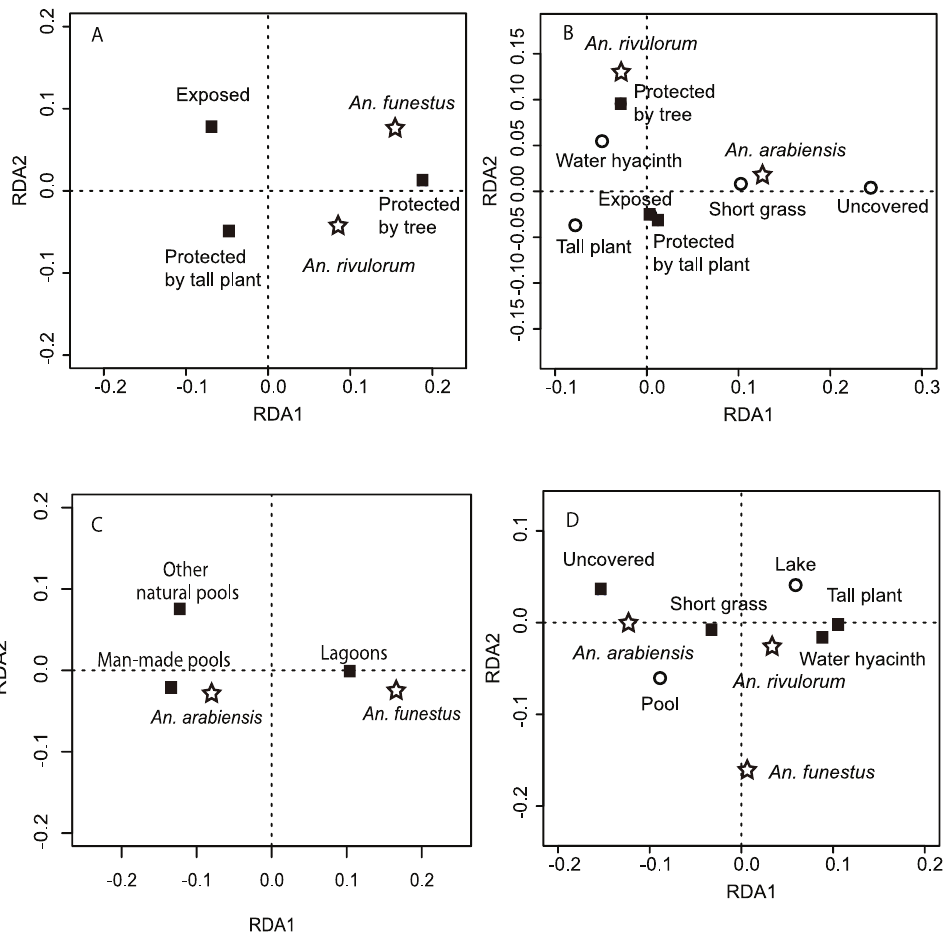
Figure 2. Redundancy analyses results showing the relationship between the vector species and the environmental factors for each habitat type: (A) hyacinth habitats, (B) lake habitats, (C) adjacent habitats, and (D) lake and adjacent habitats. Only the significant explanatory variables are included in the plots. The first axis was significant in the biplot for all cases, but the second axis was not significant in the analysis with water hyacinths.